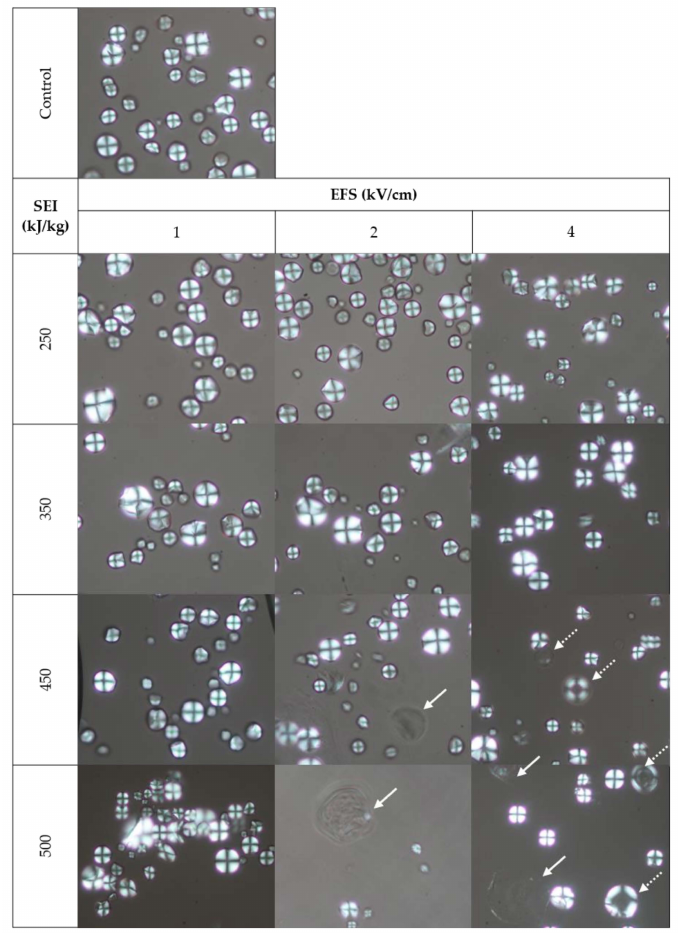
Figure 2. Polarized micrographs at 400 × of “control” and PEF-treated cassava flour starches. Images show swollen starch granules with complete (solid arrow) and partial loss of birefringence (dashed